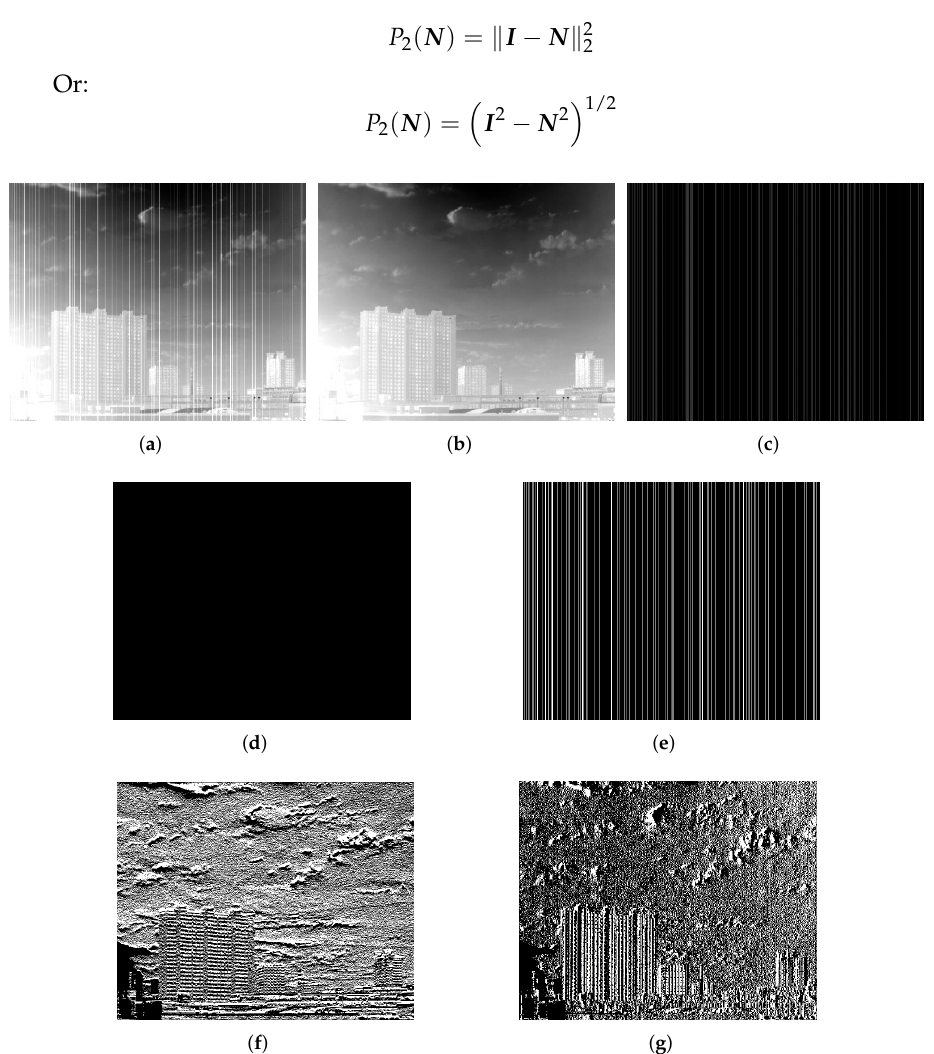
Figure 2. Difference between information components and stripe noises: ( a ) Original image; ( b ) Information components; ( c ) Noise components; ( d ) Vertical gradient of noise components; ( e ) Horizontal gradient of noise components; ( f ) Vertical gradient of information components; ( g ) Horizontal gradient of information components.